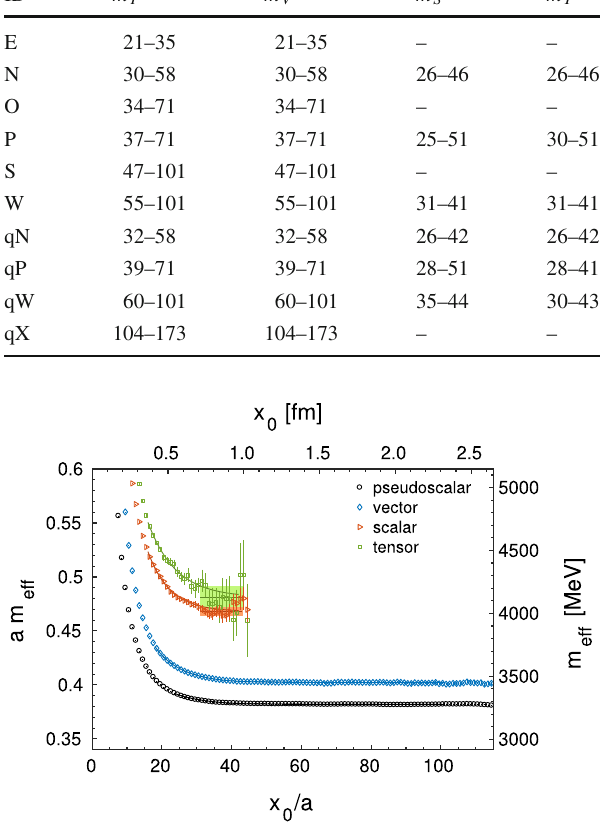
Fig. 4 The effective masses on the W ensemble for the pseudoscalar (circles), vector (diamonds), scalar (triangles) and tensor (squares) channels are displayed, together with the plateau average and its error band. The fit to the leading correction Eq. (4.1) is also shown